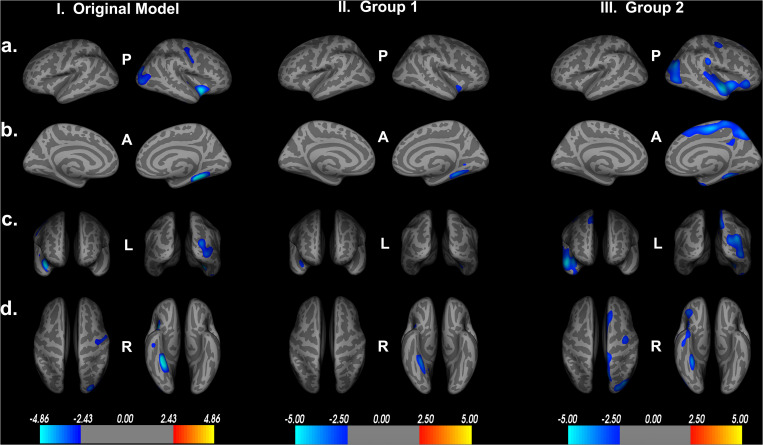
Random group assignment cortical thickness findings (n = 93 for each group; total n = 186). Significant clusters set at p > 0.01. (a) left and right hemisphere lateral views, respectively. (b) left and right hemisphere medial views, respectively. (c) anterior and posterior views, respectively. (d) superior and inferior views, respectively. P- posterior, A- anterior, L- left, R- right.